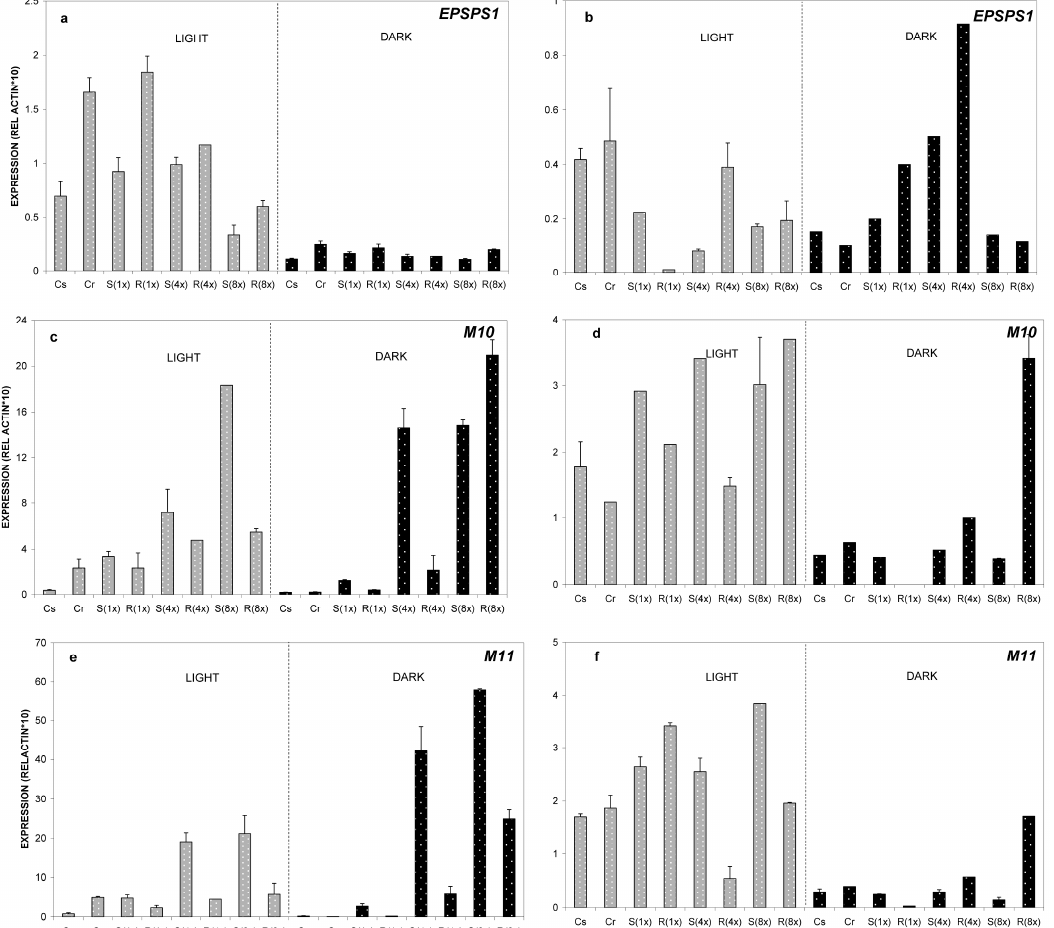
Figure 4. Relative expression of EPSPS1 ( a , b ), M10 ( c , d ), and M11 ( e , f ) genes analyzed by real time PCR. Relative quantification was obtained through the 2 ΔΔ C t method using actin as the reference gene. As a reference sample the untreated (control) plants from the susceptible biotype, was chosen (Cs). Data represent the average from three biological replicates and the error bars indicate the standard deviation. Leaves were collected from plants grown at 8 °C. Explanation of samples abbreviations was given on Figure legend 2. Relative expression ratios were estimated one and four days after glyphosate treatment (one DAT—diagrams on the left, and four DAT—diagrams on the right).